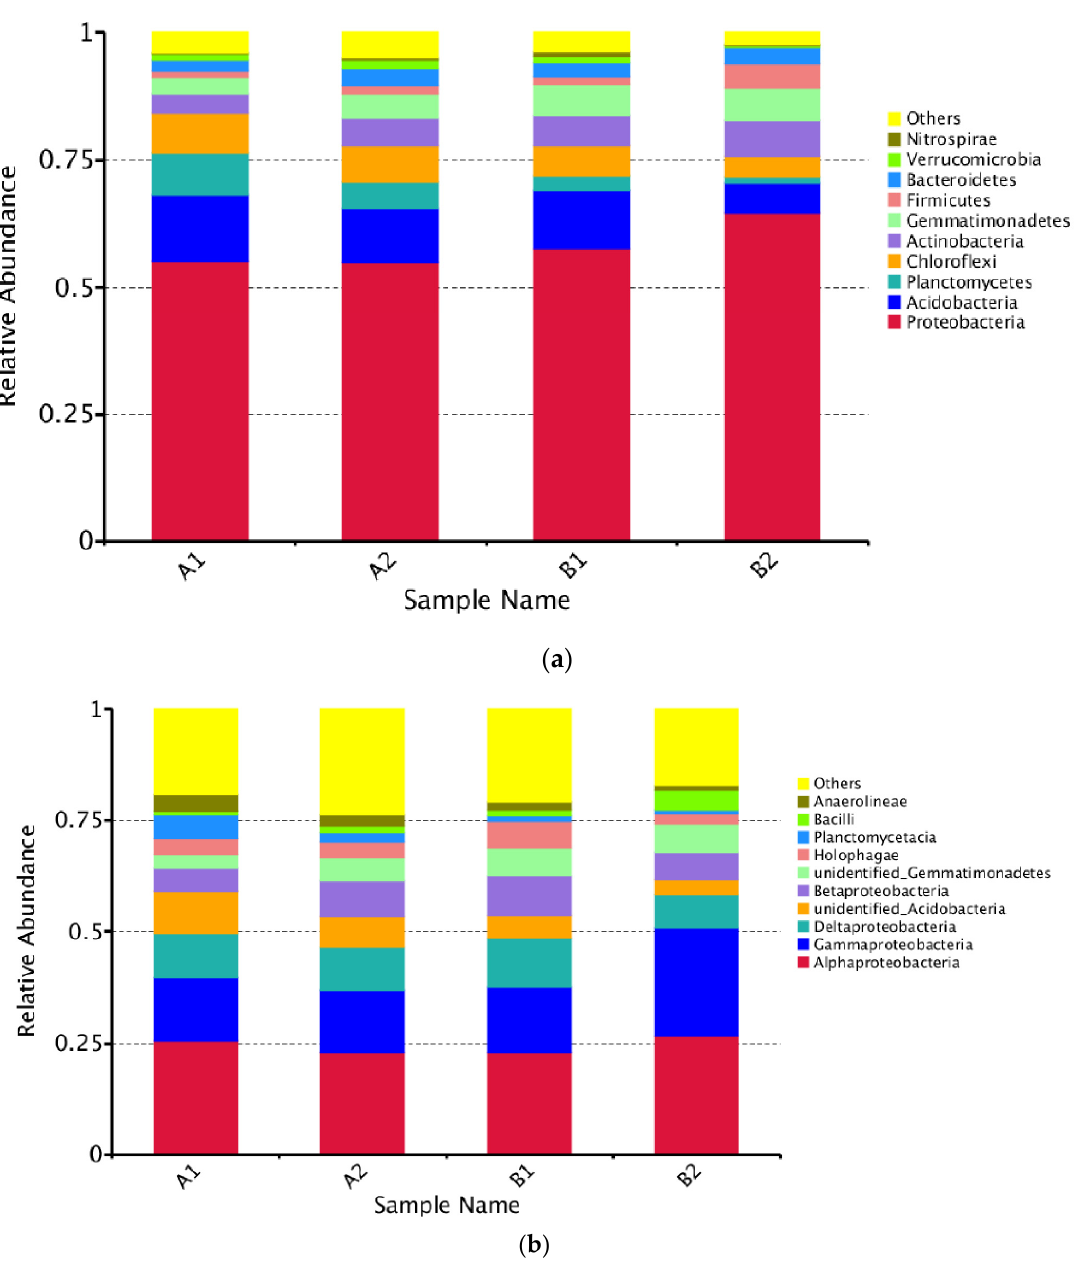
Figure 8. Relative abundance at phylum level ( a ); relative abundance at class level ( b ).